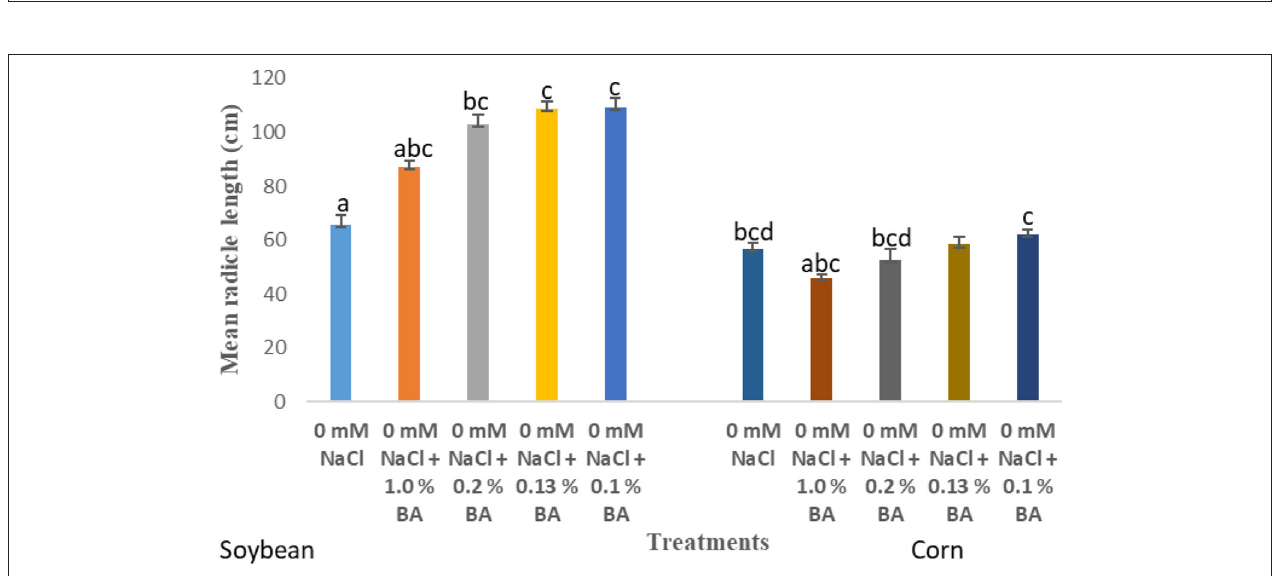
FIGURE 2 | Effect of treatment on the mean percentage germination of corn and soybean, at 24h, under optimal conditions. Treatments with similar letters are not significantly different. Treatments with different letters are significantly different.